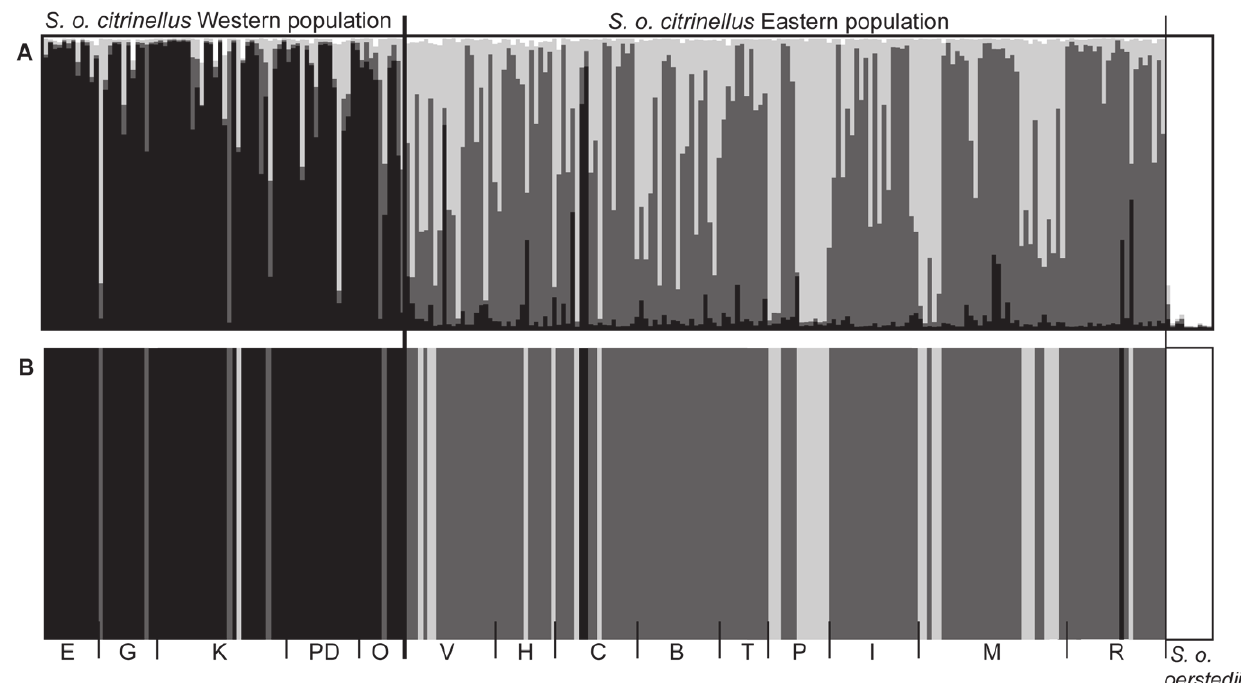
Figure 2. Distribution of three genetic clusters estimated in STRUCTURE (A) and BAPS (B). Vertical lines are broken into colored segments showing the proportion of each individual assigned to each K (within S. o. citrinellus : western cluster – black, eastern cluster 1– light grey, eastern cluster 2– grey; S. o. oerstedii – white). Sample locations are listed at the bottom of the figure, and are arrayed in west to east order (left to right).